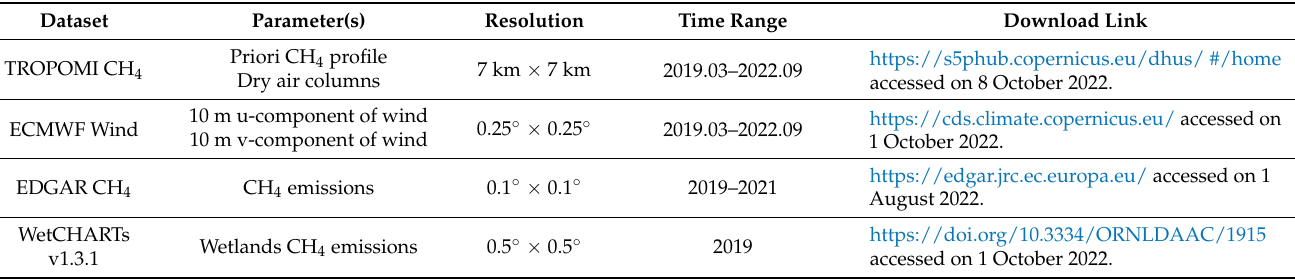
Table 1. Description of data used in the